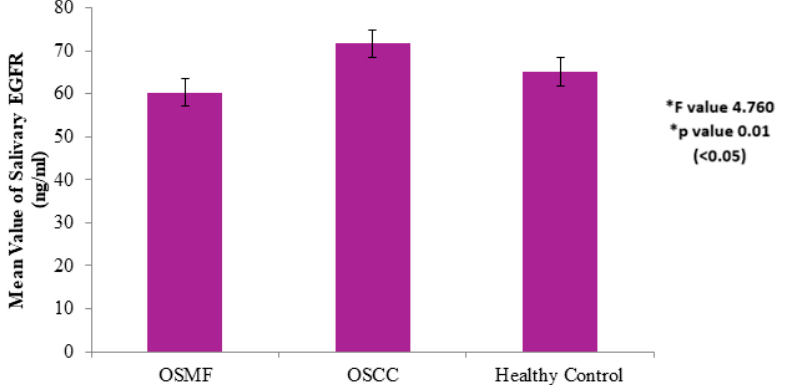
Figure 1. Salivary EGFR levels of healthy controls vs. OSMF vs. OSCC. * Values are expressed as mean ± SD. Statistical significance analyzed by Dunnett’s T3 post-hoc test at p < 0.05.